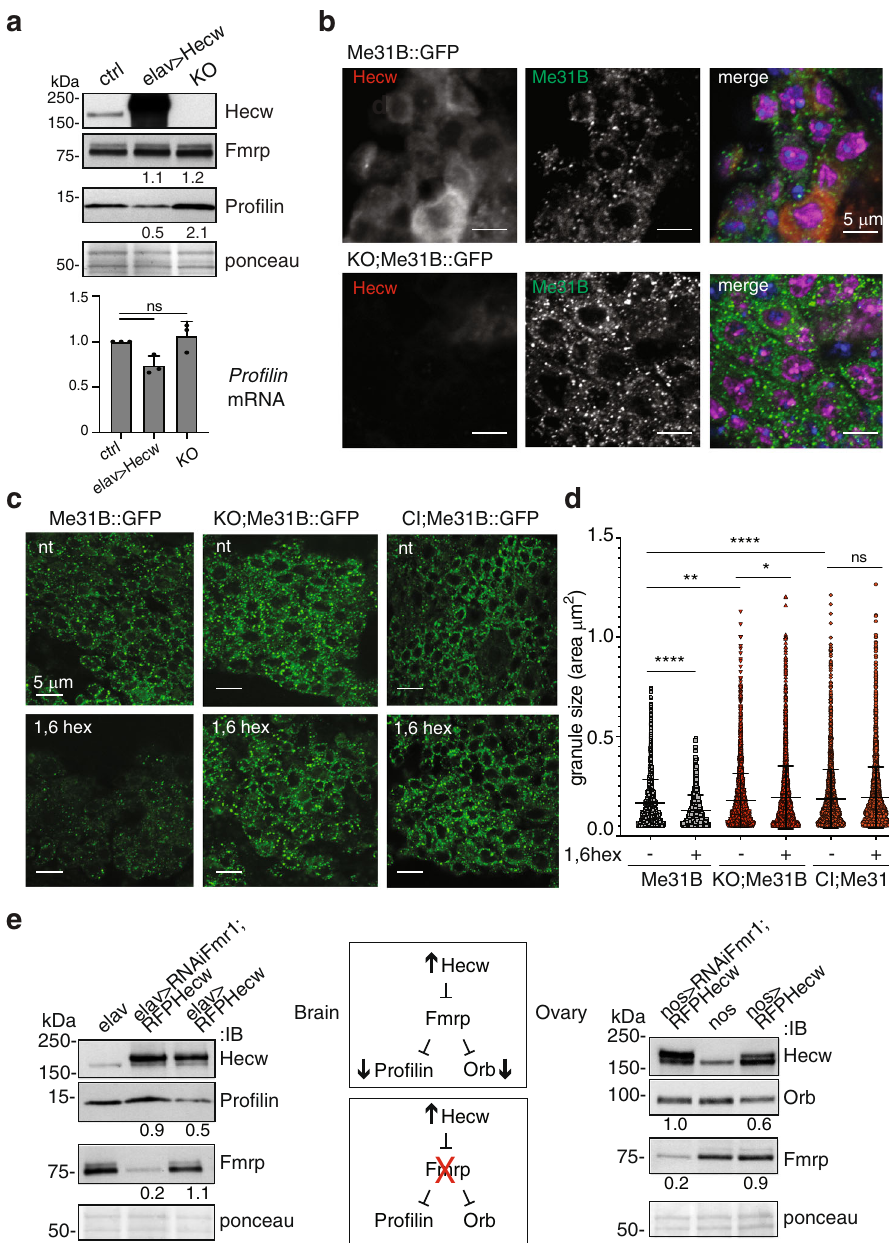
Fig. 8 Lack of Hecw alters RNP in neurons. a Upper panel: IB of wild-type (ctrl) , Hecw KO (KO) and RFP-Hecw-overexpressing ( elav>RFP Hecw ) fl y heads with the indicated antibodies. Pro fi lin levels increase in Hecw KO and decrease upon Hecw overexpression. Values reported below each blot are normalised for tubulin and represent the fold change relative to the control, presented as mean of three experiments. Bottom panel: mRNA level of pro fi lin was measured by qPCR in the adult heads of the indicated genotypes. The reported expression levels relative to control are expressed as mean ± SD calculated over three experiments. Ns, not signi fi cant by unpaired two-tailed t -test. b IF analysis of adult brains from 1-day-old fl ies with the indicated antibodies ( n = 2). Neurons are marked with the anti-elav antibody (purple); red, Hecw; blue, DAPI. Scale bar, 5 μ m. c IF analysis of adult brains from 1-day-old fl ies of the indicated genotypes, not treated (nt) or treated with 1,6 hexanediol (1,6 hex). ( n = 3). Scale bar, 5 μ m. d Quanti fi cation of RNP size in fl y neurons of the indicated genotypes and conditions. RNP size is signi fi cantly increased in Hecw KO fl ies (KO;Me31B::GFP ** P < 0.01) and Hecw CI (CI;Me31B::GFP ** P < 0.01). 1,6 hexanediol treatment signi fi cantly reduces RNP size in control fl ies. Size mean ± SD is reported. **** P < 0.0001 by two-tailed Mann – Whitney test (ten heads/genotype from two biological replicates). e Pro fi lin and Orb levels are restored upon concomitant Hecw overexpression and Fmr1 silencing. Left panel: Pro fi lin expression in fl y brains of the indicated genotypes. Values reported below each blot are normalised for tubulin and represent the fold change relative to the control, presented as mean of three experiments. Right panel: Orb expression in fl y ovaries of the indicated genotypes. Values reported below each blot are normalised for tubulin and represent the fold change relative to the control, presented as mean of two